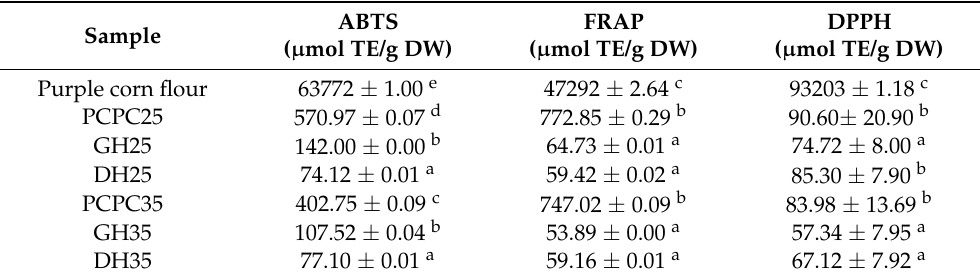
Table 5. Antioxidant activity of PCPC25, PCPC35 and their gastrointestinal hydrolysates (GH25, DH25, GH35 and DH35) by ABTS, FRAP and DPPH